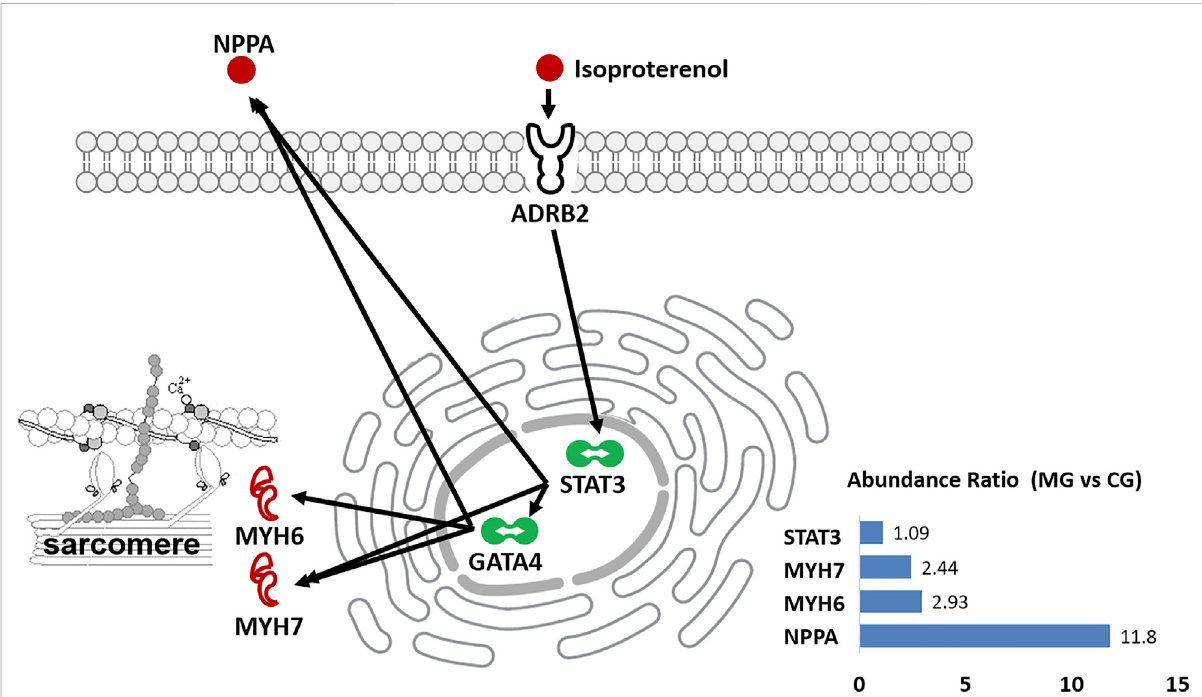
FIGURE 7 Diagrammatic process of isoproterenol-induced heart dysfunction in rats. It shows that isoproterenol binds to ADRB2 and upregulates the expression of NPPA, MYH6, and MYH7 via activating the transcriptional regulators STAT3 and GATA4. The inset shows the abundance ratio of the selected proteins expressed in the heart of controls (CG) and models